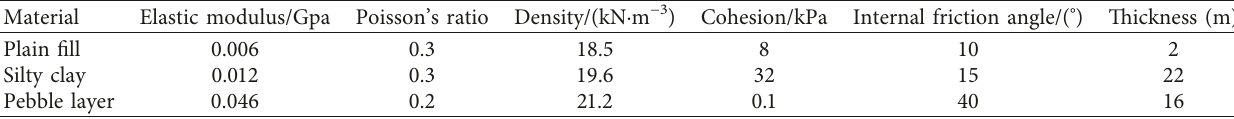
Table 1: Material physical and mechanical parameters table.